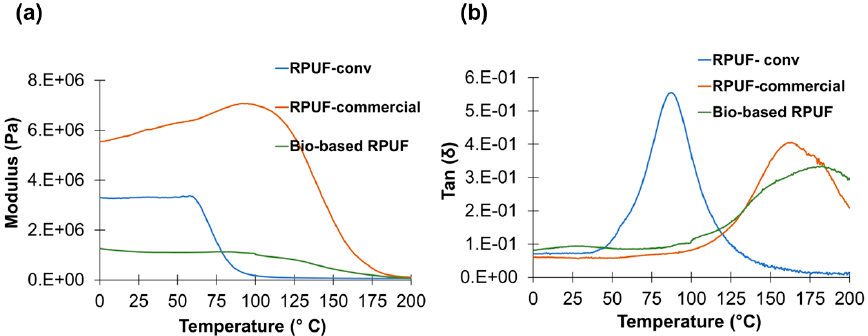
Figure 5. Thermo-mechanical properties of optimized bio-based RPUF, RPUF-conv, and RPUF-commercial ( a ) storage modulus curve, ( b ) tan δ curve at 1 Hz.